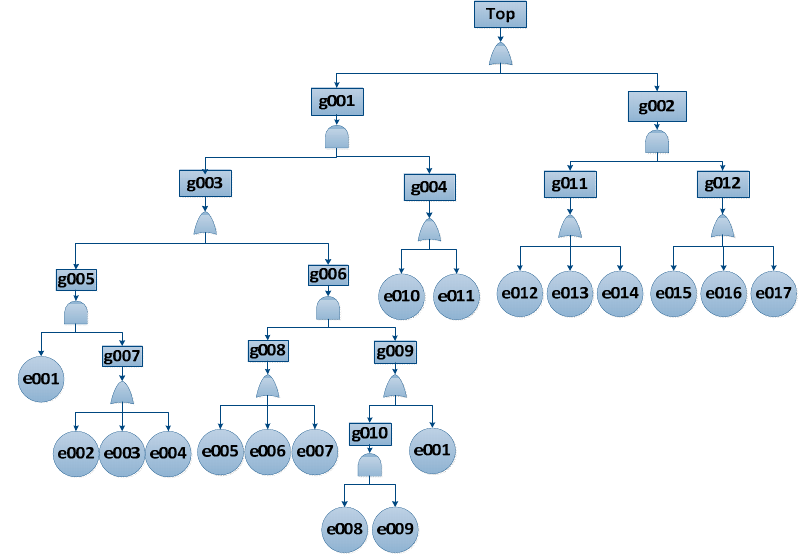
Figure 8. Fault tree of the generator, electrical and electronic components.